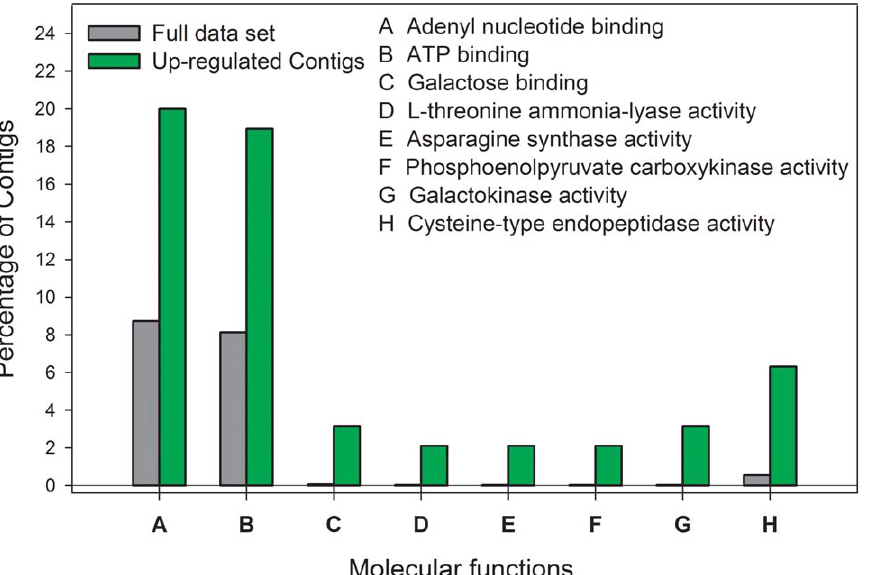
Figure 5. Molecular functions over-represented in the sensitive genotype (S) after an Enrichment Analysis. The bars show the percentage of contigs associated with each GO term. The dark gray show the percentage of contigs associated with each GO term considering the full microarray data set. Green bars show the percentage of contigs associated with each GO term but only in the up-regulated date set.